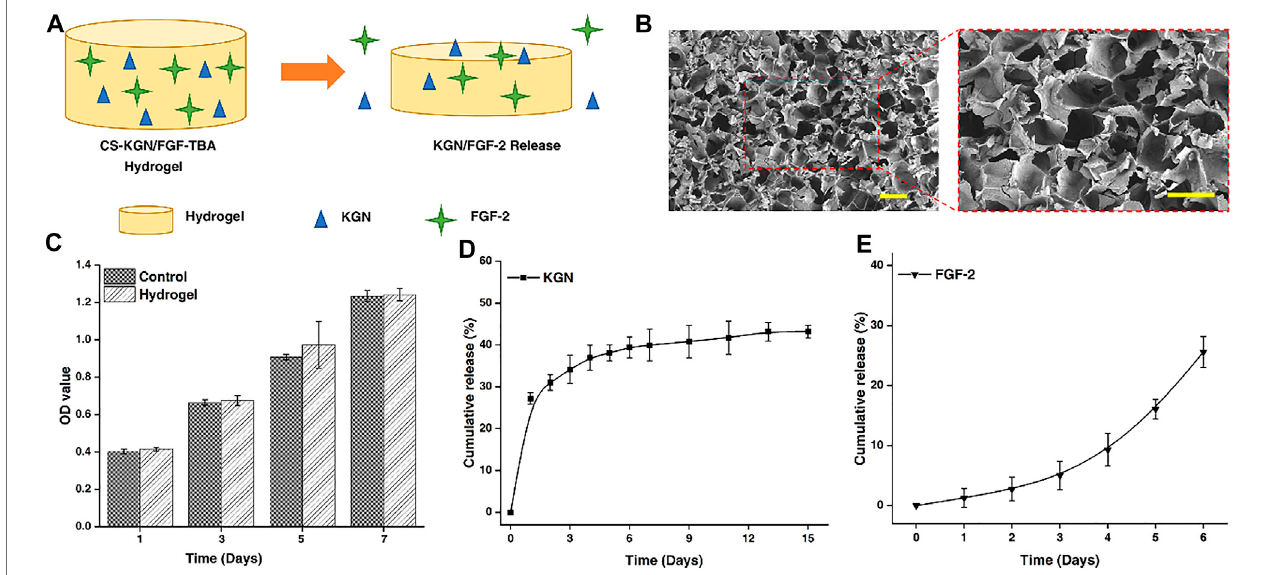
FIGURE1|(A) Schematicofdual-factor containingandreleasingCS-TBAhydrogel. (B) SEMimagesoftheCS-TBAhydrogel(scalebar:200 μ m). (C) Cytotoxicity of CS-TBA hydrogel at 1, 3, 5, and 7 days. (D) Releasing curve of KGN from the CS-TBA hydrogel. (E) Releasing curve of FGF-2 from the CS-TBA hydrogel.